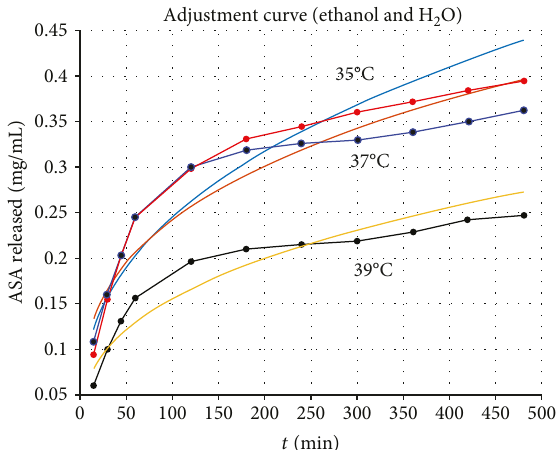
Figure 8: Adjustment curve for ASA released with ethanol-water solution experimental data using